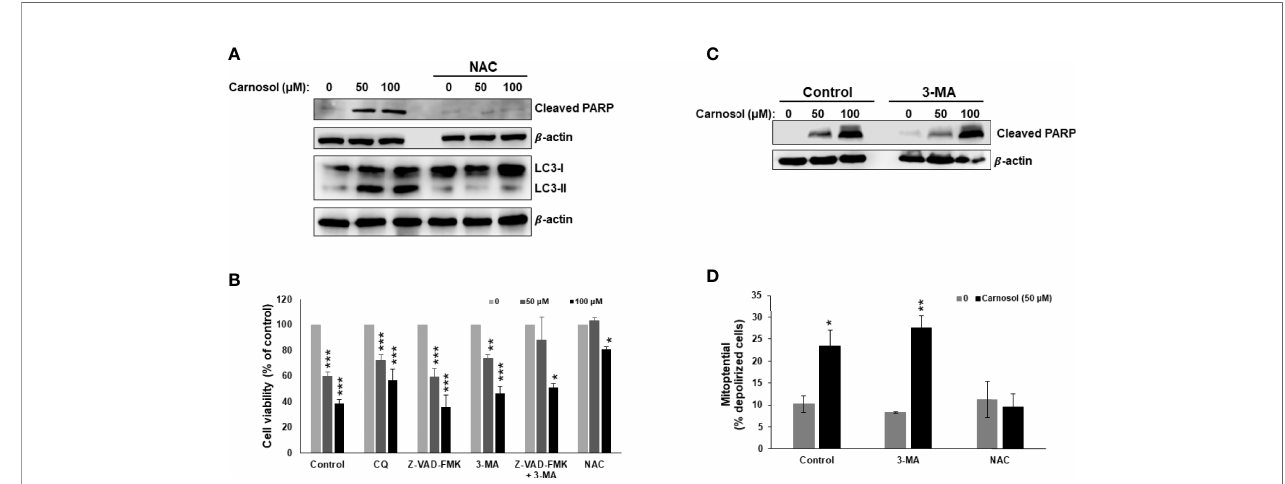
FIGURE 1 | Carnosol induces breast cancer cell death through activation of PCD-I and PCD-II pathways. (A) ROS-dependent LC3II accumulation and PARP cleavage in carnosol-treated MDA-MB-231 cells. Cells were pre-treated with the ROS scavenger NAC (10mM) before adding carnosol at the indicated concentrations for 24 hours. Whole cell lysates were analyzed by Western blot for LC3II and cleaved PARP. (B) Inhibition of autophagy but not apoptosis reduces carnosol-induced cell death. MDA-MB-231cells were pretreated with the inhibitors of autophagy CQ (50 m M) and 3-MA (10mM), or the pan-caspase inhibitor (Z-VAD-FMK) (50 m M) alone or in combination then treated with carnosol for 24 hours. Cell viability was determined as described in Material and Methods. (C) Western blot of cleaved PARP in cells pretreated with and without autophagy inhibitor. (D) Inhibition of autophagy failed to restore the carnosol-induced loss of mitochondrial membrane potential in MDA- MB-231 cells. Mitochondrial membrane potential (MMP) of cells pre-treated with 3-MA or NAC, prior to the addition of carnosol for 24 hours, was assessed with the Muse Cell Analyzer using the Muse MitoPotential kit as described in Materials and Methods. Data represent the mean ± SEM of at least 3 independent experiments. Student ’ s t-test was performed to determine the signi fi cance (*p<0.05, **p<0.005, and